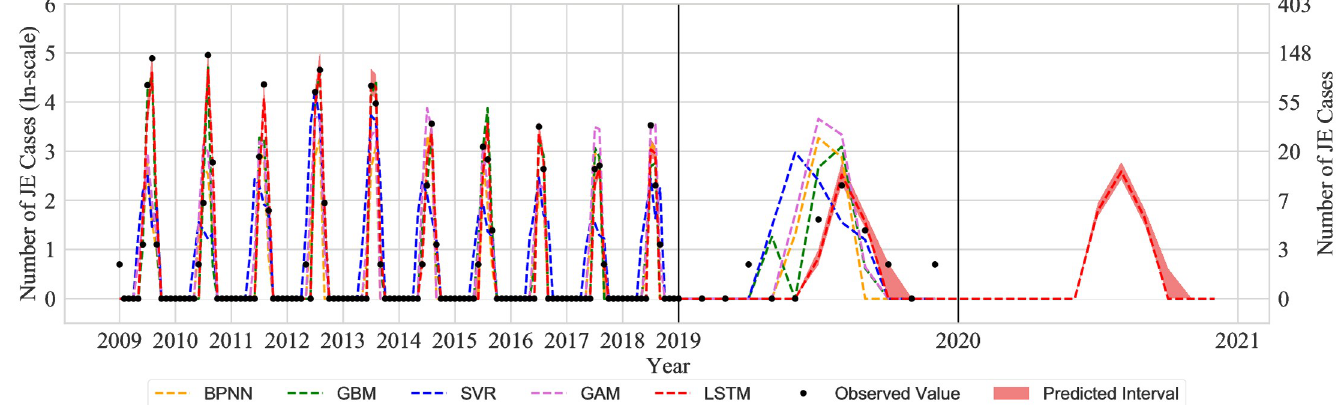
Fig 5. Time series of the incidence of JE in Chongqing. Data from 2008–2017 were used to train the LSTM model, data from 2018 were used as validation set and data from 2019 were utilised for model testing. In the figure, the observed values are represented by the black point, the predicted values of BPNN are represented by yellow line, the predicted values of GBM are represented by green line, the predicted values of SVR are represented by blue line, the predicted values of GAM are represented by purple line, the predicted values of LSTM are represented by red lines and the predicted interval of LSTM is represented by a light red area.